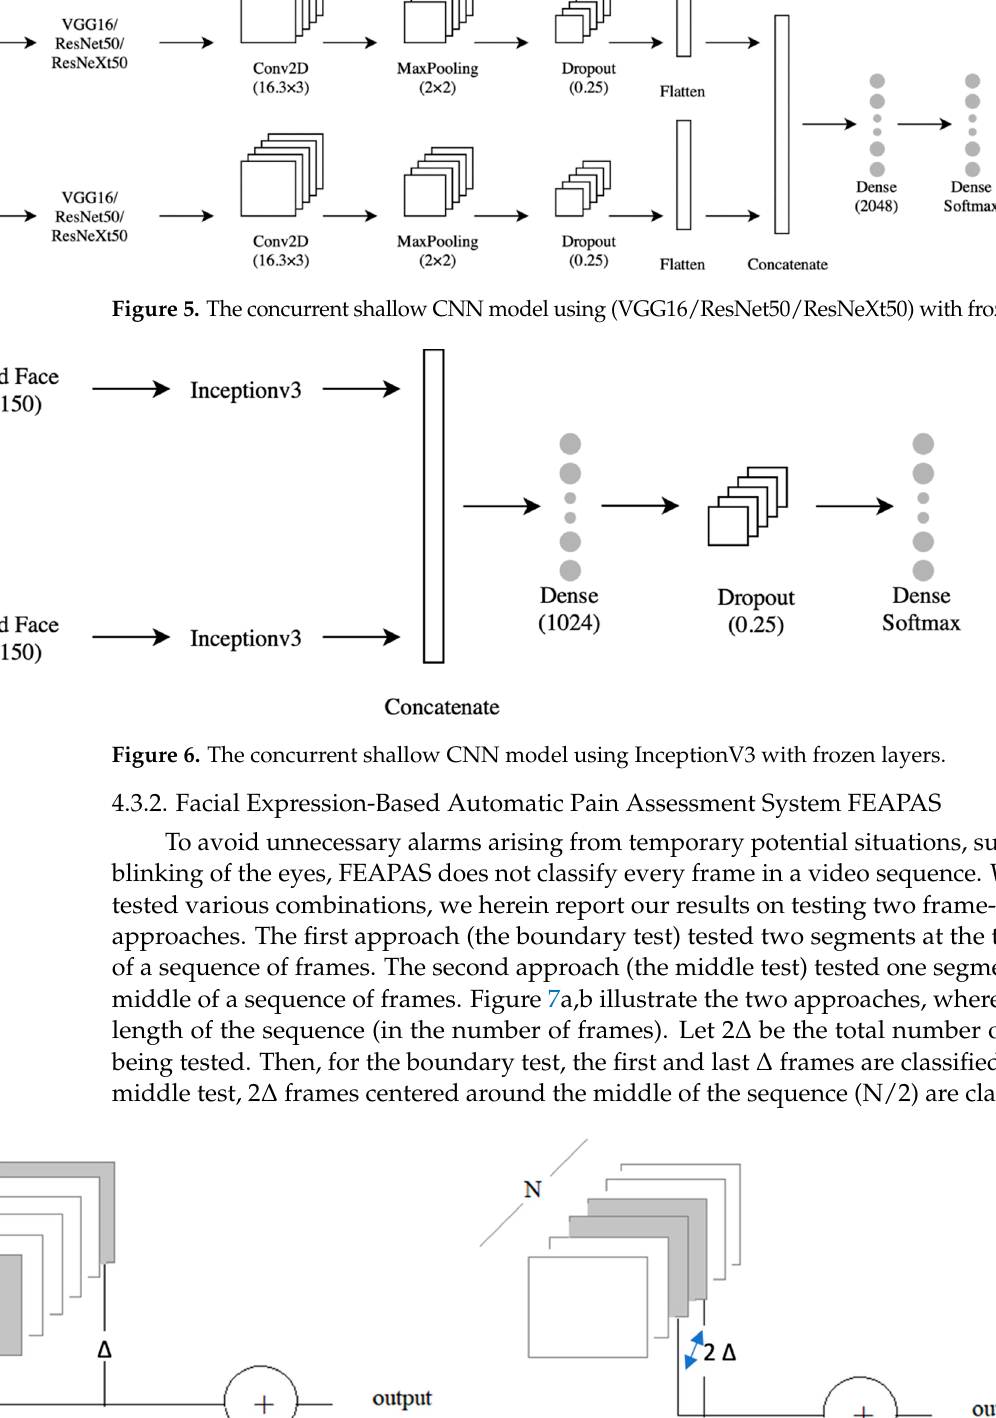
Figure 5. The concurrent shallow CNN model using (VGG16/ResNet50/ResNeXt50) with frozen lay- ers.